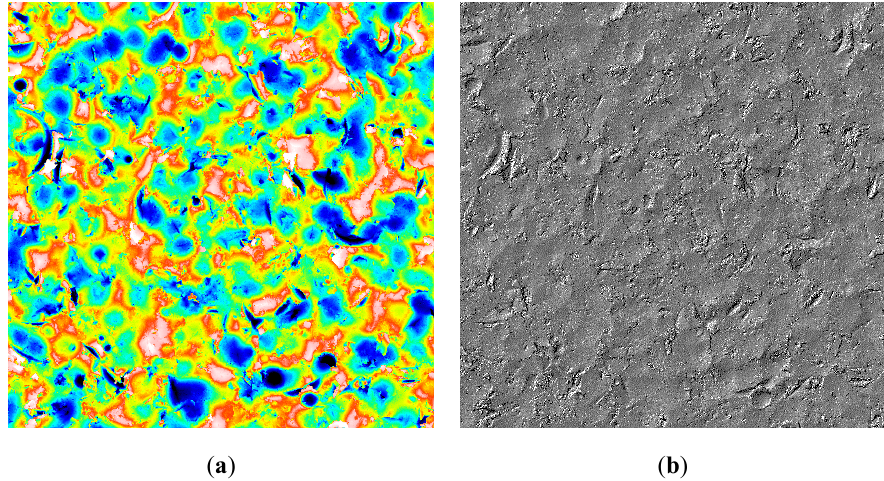
Figure 3. Example of blasted TA6V surface topography ( a ) and an associated reflectance map ( b ).